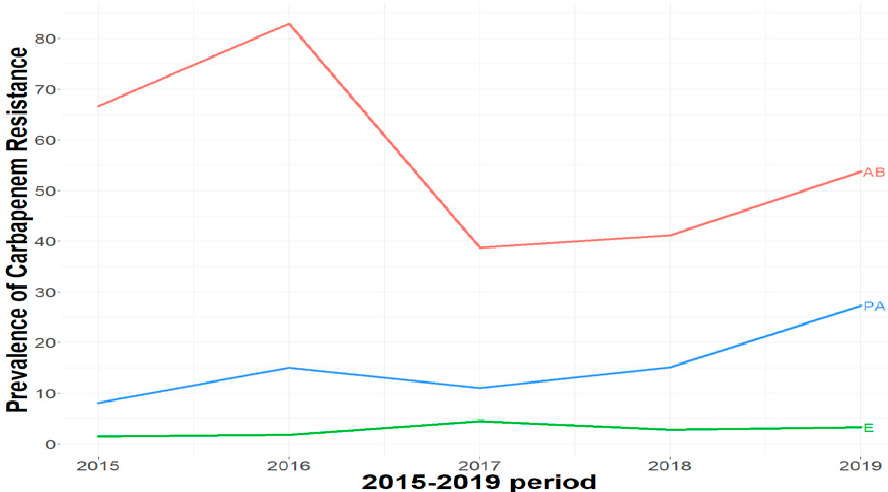
Figure 1. The evolution of carbapenem resistance among Enterobacterales (E), P. aeruginosa (PA) and A. baumannii (AB) isolates in northern Lebanon from 2015 to 2019.